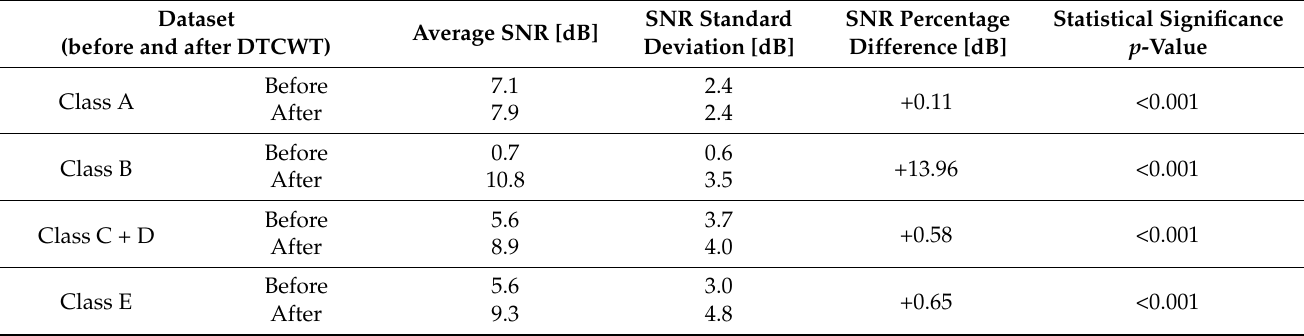
Table 3. The SNR measurements before and after DTCWT for all HS recordings in the